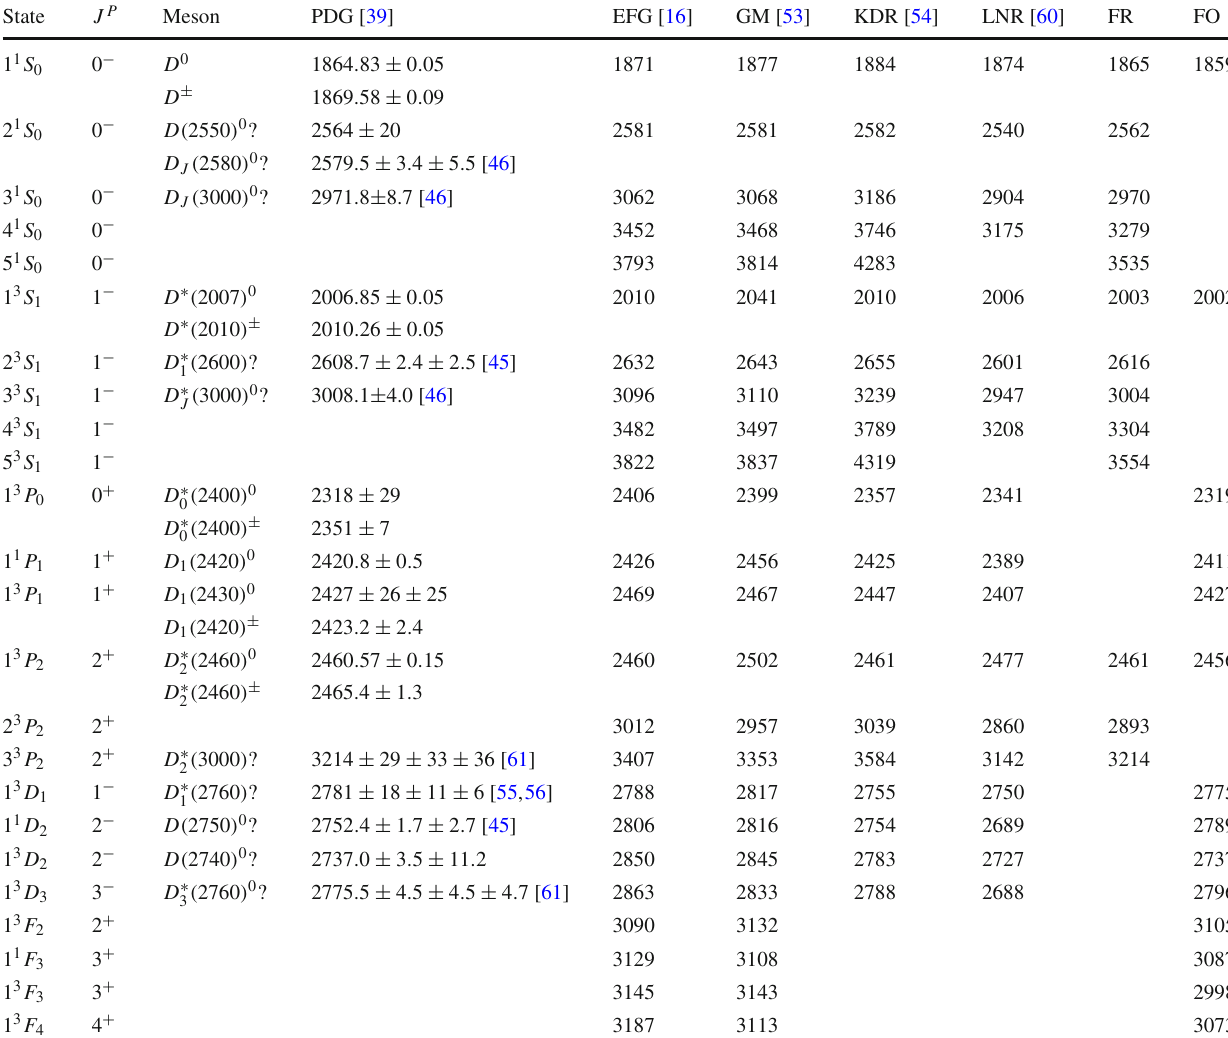
unwell-established states or the mesons needing confirmation. FO and FR denote the fitted results by the orbital Regge trajectories and by the radial Regge trajectories,